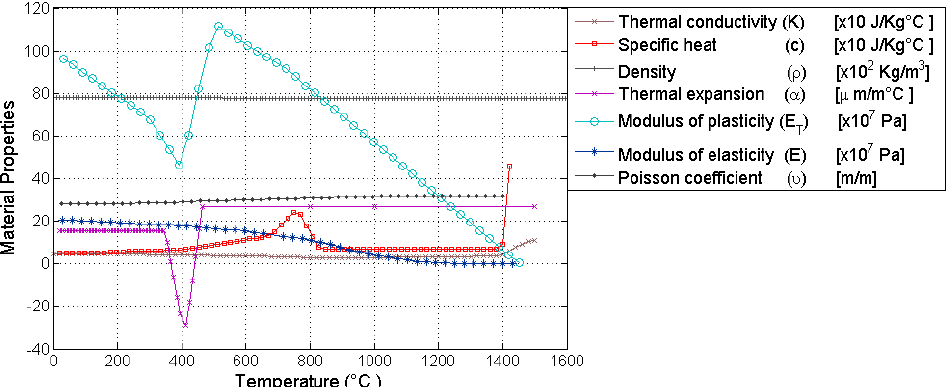
Figure 2. Thermal and mechanical properties of the API 5L X70 steel as a function of the temperature adopted in the simulations performed here.